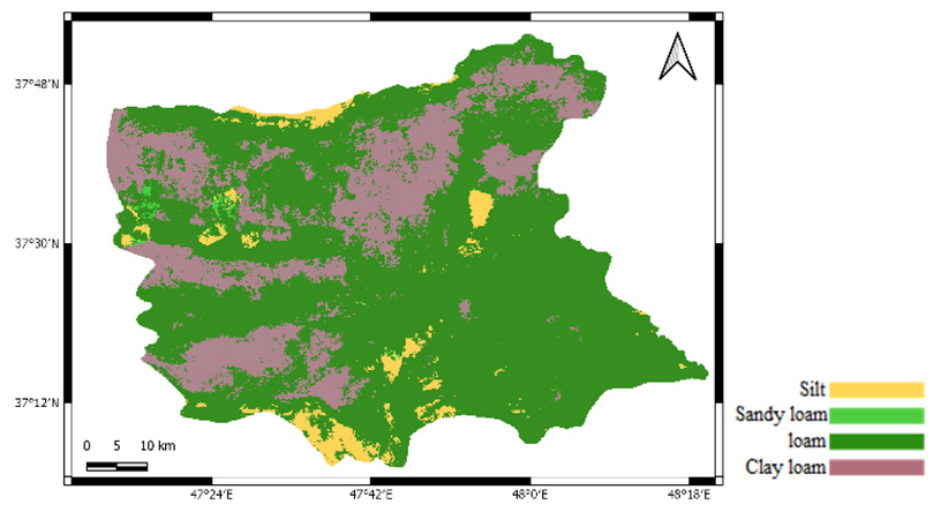
Figure 2. Soil type map.